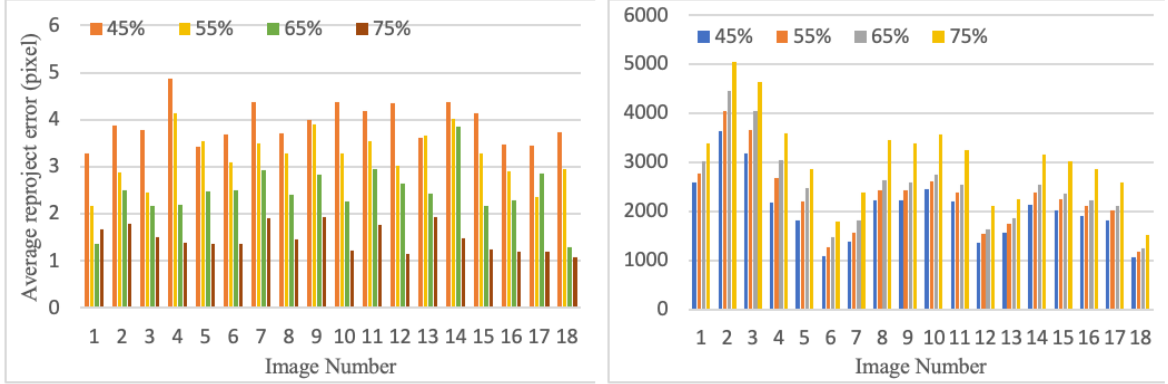
Figure 11. Results for the multi-strip block image orientation: average re-projection error of the bundle adjustment for each image (a) and number of tie point (b).